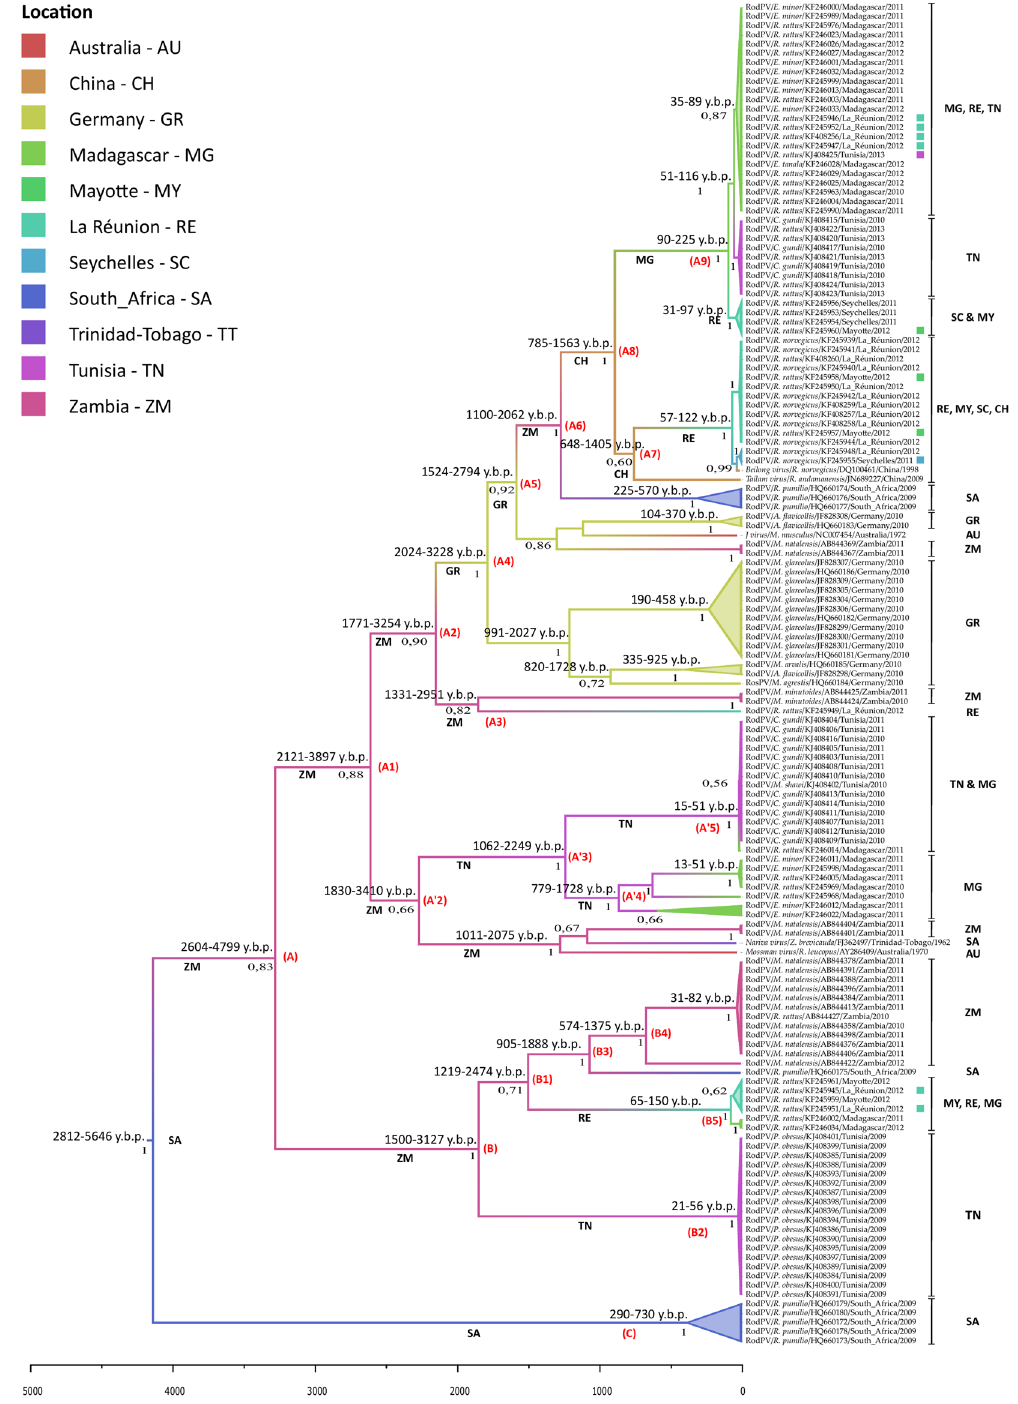
Figure 2. Maximum clade credibility tree of Rodentia associated UMRV . The phylogenetic relationships and temporal evolutionary history have been estimated based on molecular clock analysis. Branch lengths are temporally scaled, and the x-axis presents a time scale (years before present). The tree branches are colored following the most probable location of their descendent nodes as specified in the figure. Geographical groups are identified according to the origin of the UMRV . Viruses preceded by a small colored square indicate a spillover event between Rattus rattus and other Rodentia species with the color indicating the location of the spillover. Node points indicate Bayesian posterior probabilities and the 95% HPD. Virus designations are as follows: Virus name or virus affiliation/host/Genbank accession number/country of origin/collection year/host family. Abbreviations used are detailed in Supplementary Data